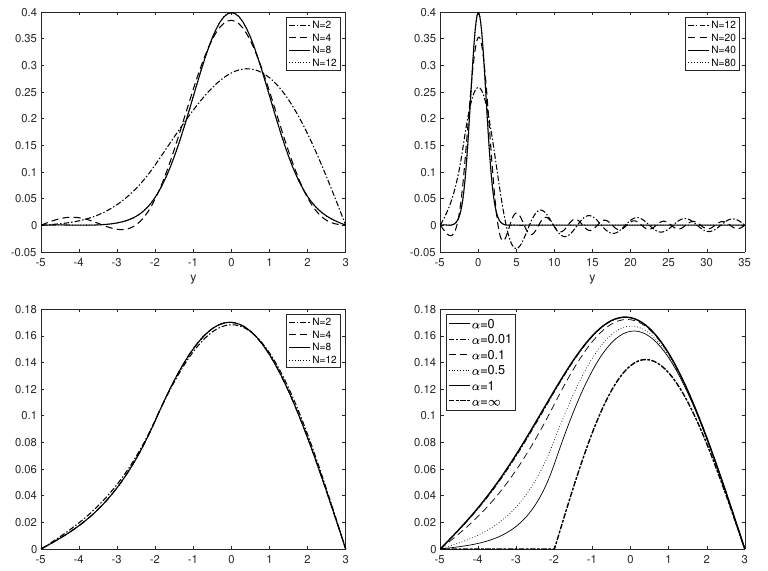
Figure 1. Graphs of the transition density in (9) where X = W is a standard Brownian motion with a = − 5, b = 3 ( b = 35 for top-right ), (cid:96) = − 2, t = 1 ( top-left , bottom-left) t = 5 ( top-right , bottom-right ), α = 0.25 (except bottom-right ), N = 30 ( bottom-right ).